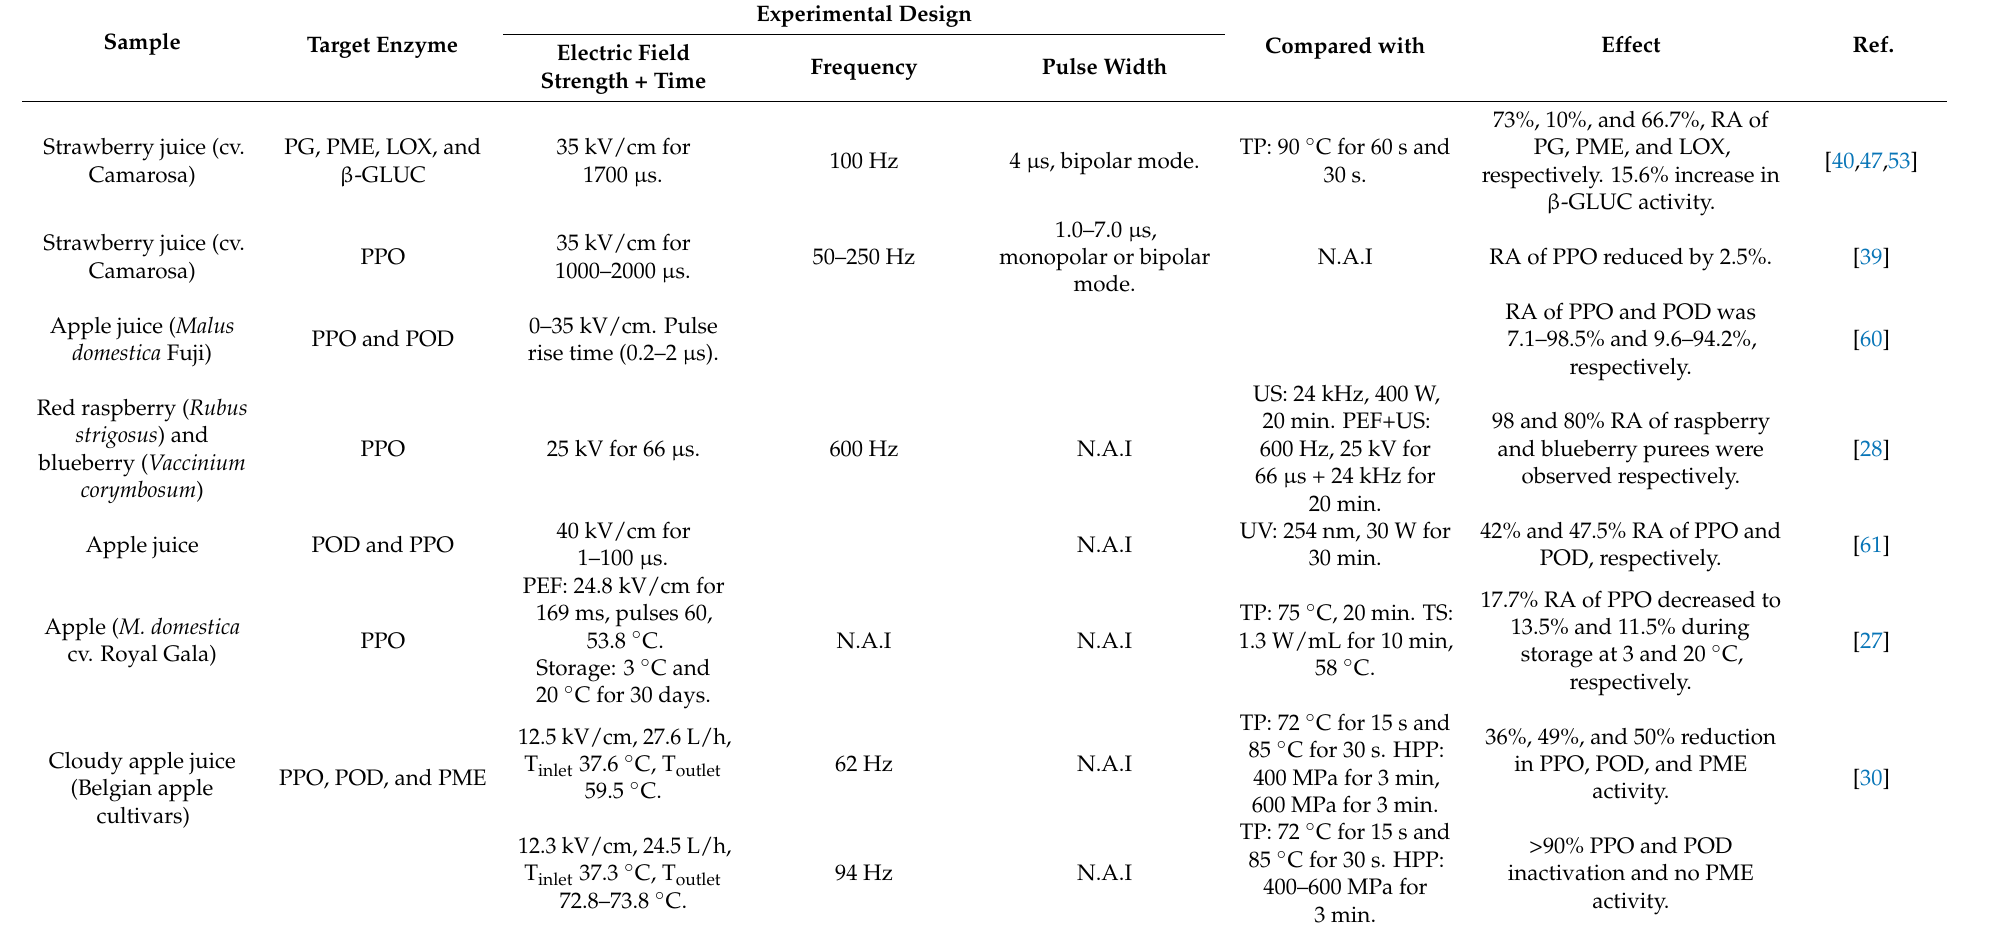
Table 1. Pulsed Electric Field Effects on the Enzymatic Profile of